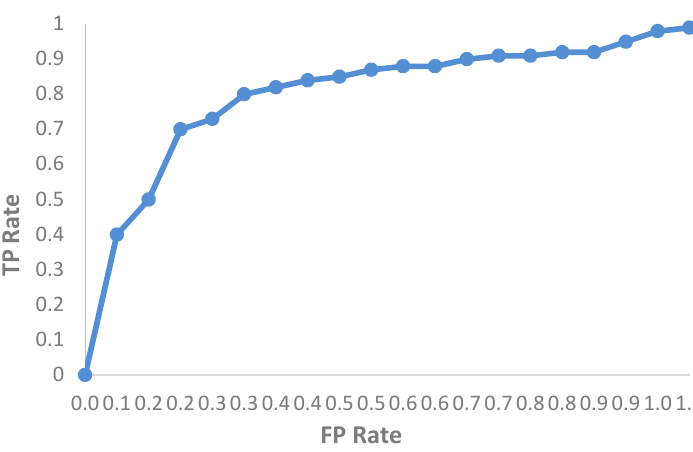
Figure 8. Receiver operating characteristic (ROC) curve for the C4.5 DT classifier.